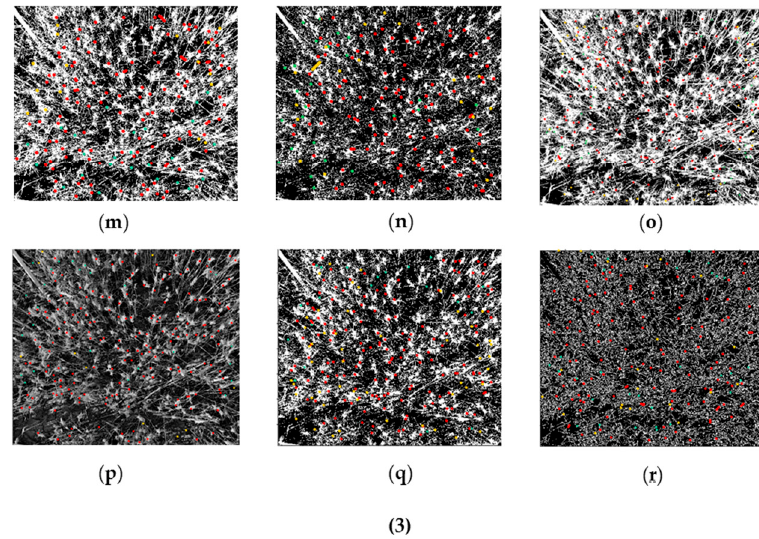
Figure 6. Segmentation results in each plot. Red regions show where artificial and machine recognition agree, blue regions show where artificial recognition and machine recognition do not agree, green regions show where the machine gives erroneous recognition. ( 1 ) Segmentation results in T 1 plot: ( a ) Proposed method; ( b ) Edge detection method; ( c ) fuzzy clustering method; ( d ) Snake model; ( e ) Minimum cut method; ( f ) region growth method; ( 2 ) Segmentation results in T 2 plot: ( g ) Proposed method; ( h ) Edge detection method; ( i ) fuzzy clustering method; ( j ) Snake model; ( k ) Minimum cut method; ( l ) region growth method; ( 3 ) Segmentation results in T 3 plot: ( m ) Proposed method; ( n ) Edge detection method; ( o ) fuzzy clustering method; ( p ) Snake model; ( q ) Minimum cut method; ( r ) region growth method.